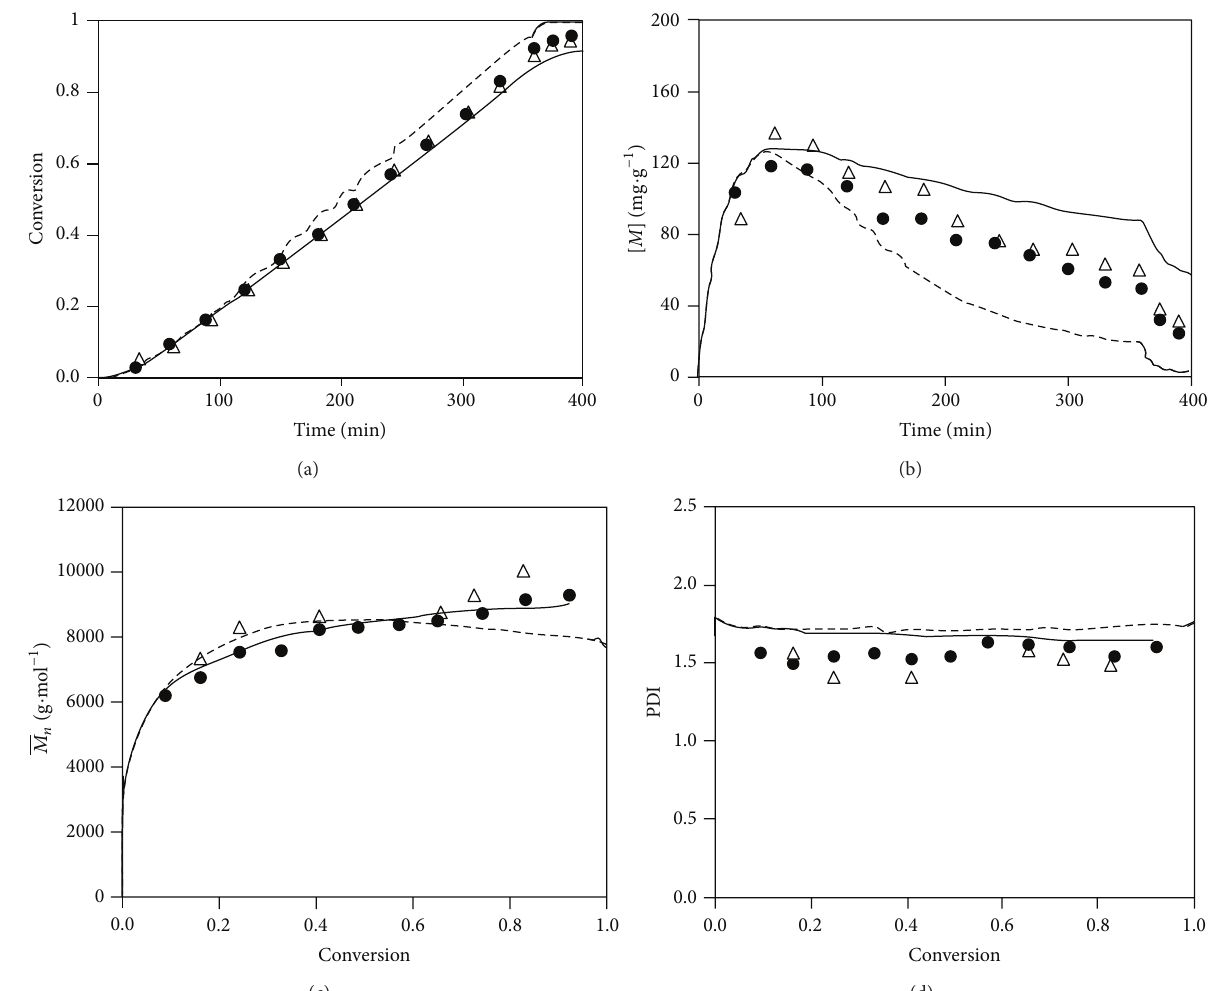
Figure 3: Free radical polymerization of styrene in semibatch reactor: (a) conversion versus time; (b) monomer concentration versus time; (c) 𝑀 𝑛 versus conversion; (d) PDI versus conversion. The solid lines are the simulation results without gel effect correlation and the dash lines are the simulation results with gel effect correlation. The dots are the experimental results. The full parameters and experimental conditions are available in